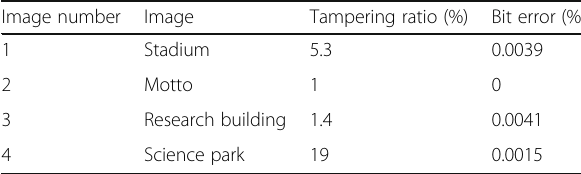
Table 3 Experiments for tampering Image number